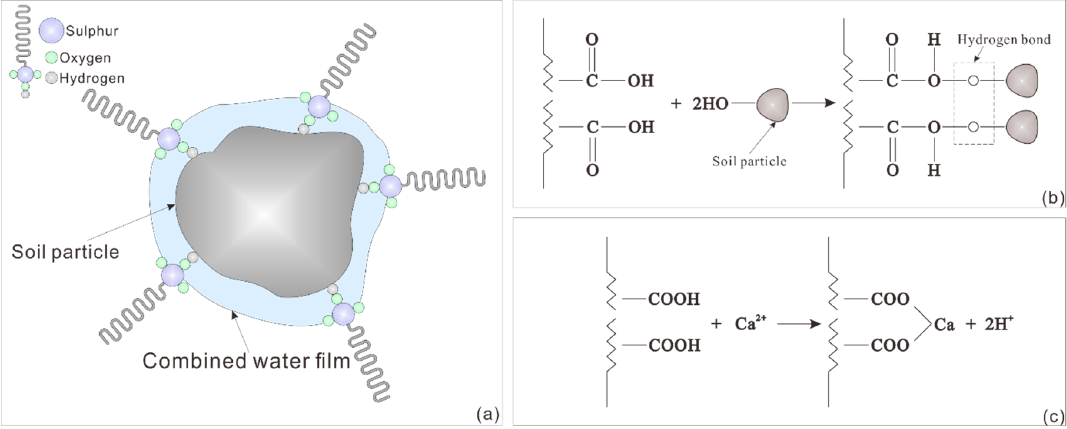
Figure 3. SEM image of section of inner soil modified with polymer: ( a ) ×450; ( b ) ×1000; ( c ) ×3000.